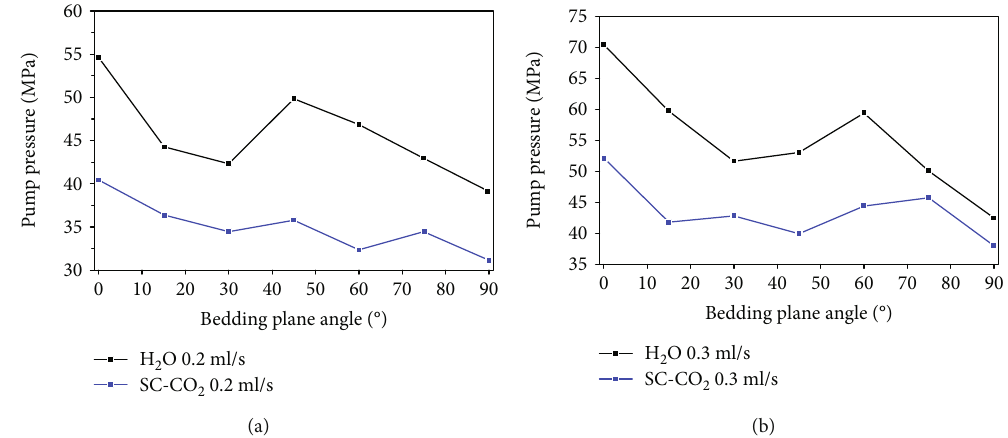
Figure 5: Variation of the breakdown pressure of fracturing using water and SC-CO with the injection rate of (a) 0.2ml/s and (b) 0.3ml/s. 2 Table 3: Comparison of shale breakdown pressure variation. No. Bedding plane angle